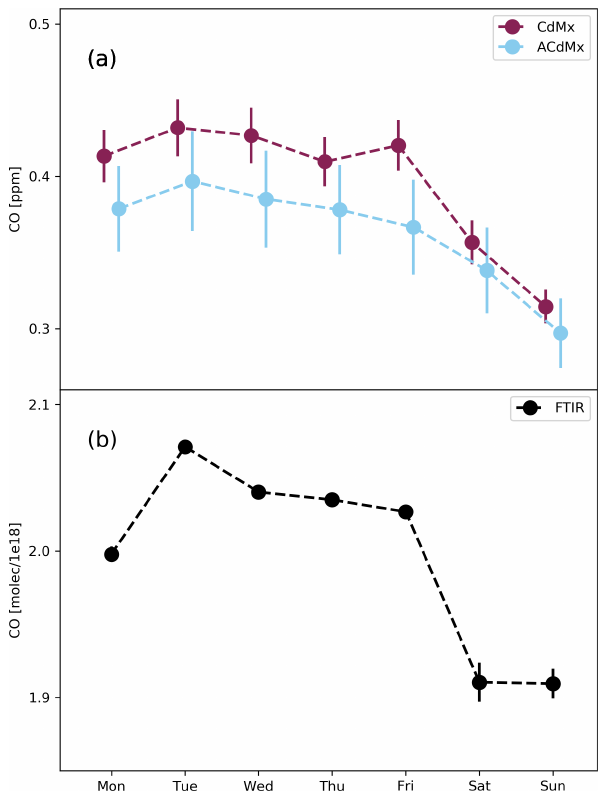
Figure 9. Weekly cycle of the CO concentration. (a) Based on 29 in situ measurement station operated by SEDEMA. (b) Ground-based FTIR vertical column measurements of an instrument located in Mexico. Median values are shown, and the error bars are the stan- dard error in the mean deploying the delta percentile as a robust estimation of the standard